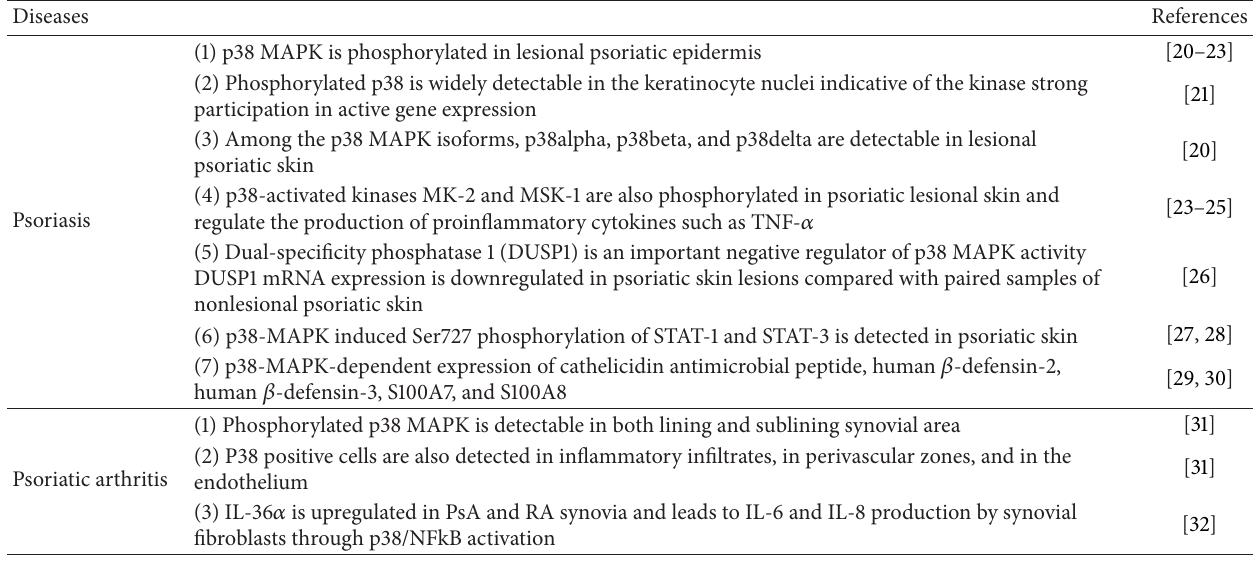
Table 2: Evidence for p38 MAPK involvement in psoriasis and psoriatic